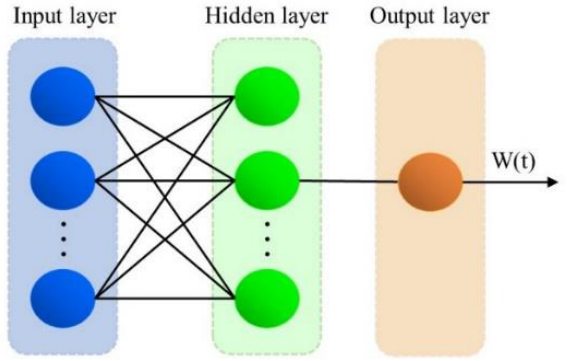
Figure 2. NARANN model structure diagram.